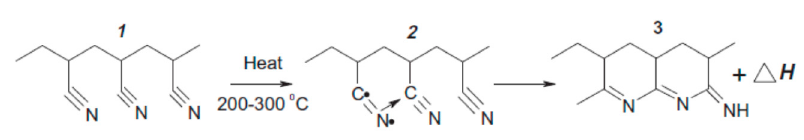
Figure 5. Cyclization reaction in polyacrylonitrile [47].